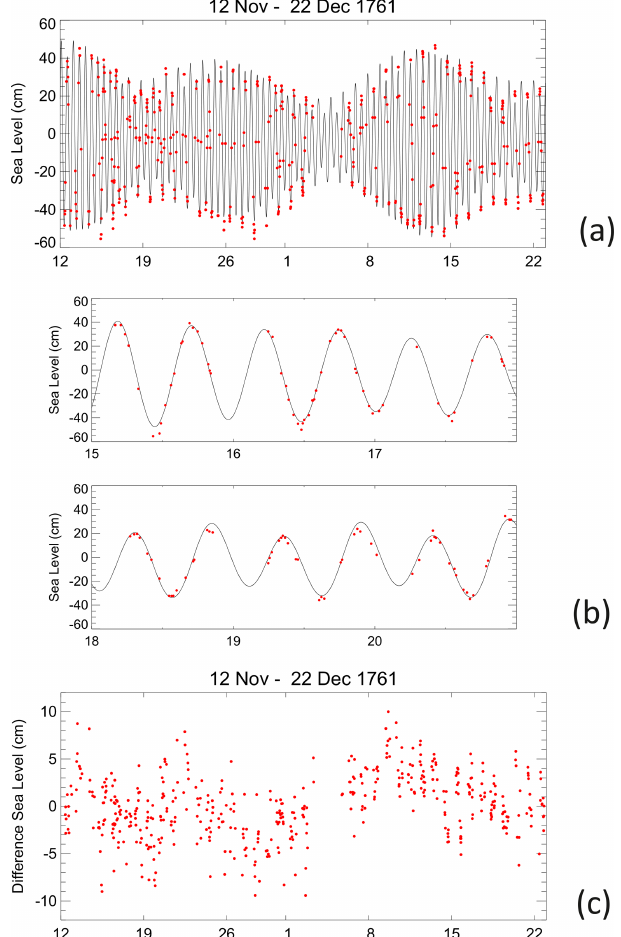
Figure 3. (a) 1min predicted heights for 12 November–22 De- cember 1761 together with the Maskelyne sea levels shown by red dots. The two sets of values have been adjusted to have zero mean. (b) A subset of (a) focussing on 15–20 November 1761 which cor- responds to Fig. 4 of Cartwright (1971), although the predicted tide will be slightly different in the two cases, and a couple of outly- ing Maskelyne’s measurements shown here appear not to have been used by Cartwright. Before and after the 6d shown, the observations of Maskelyne are mostly confined to daylight hours. (c) Sea level differences (Maskelyne − predicted) with the overall mean differ- ence removed.